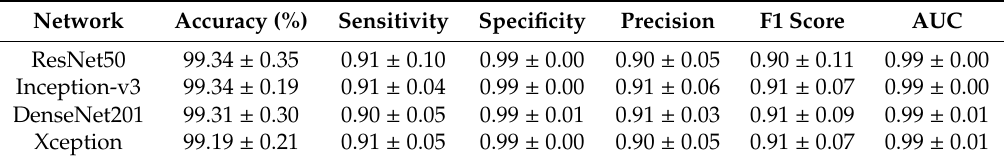
Table 9. 10-fold cross validation performance using our recommended system that included preprocessing and transfer-to-transfer learning.